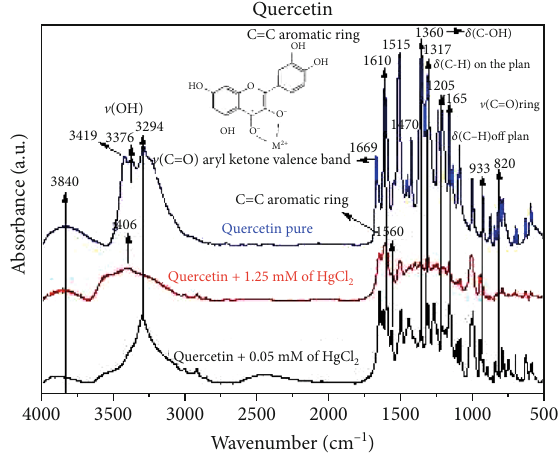
Figure 6: Spectra of pure quercetin and associated mercury chloride at 0.05mM and